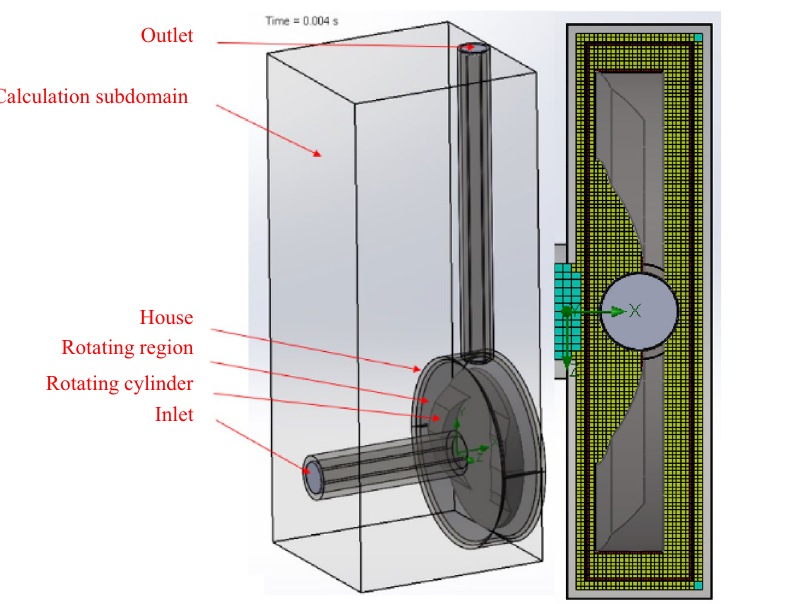
Figure 4. The simplified simulated representation and the mesh settings of the SCR